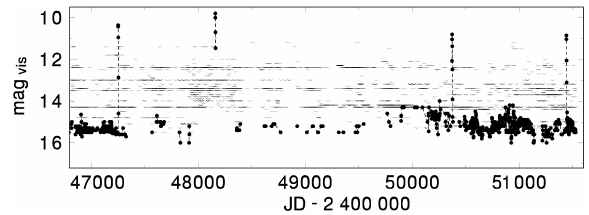
Figure 1: The light curve of the intermediate polar DO Dra with rare outbursts. The points denote the one-day means, the v symbols represent the upper lim- its of brightness. Adapted from ˇSimon